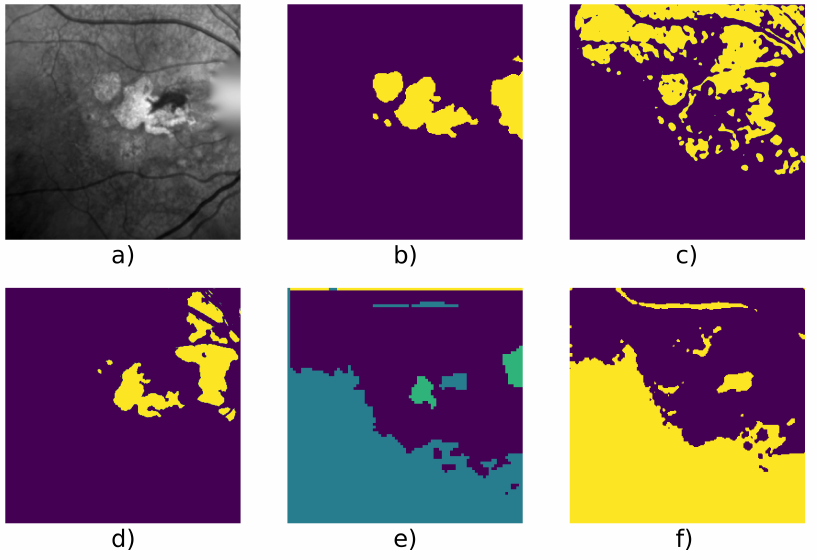
Figure 8. Patient id 010: ( a ) original image, ( b ) ground truth, ( c ) Gabor method segmentation, ( d ) W- net segmentation, ( e ) CNN + superpixel refinement segmentation, ( f ) active contour